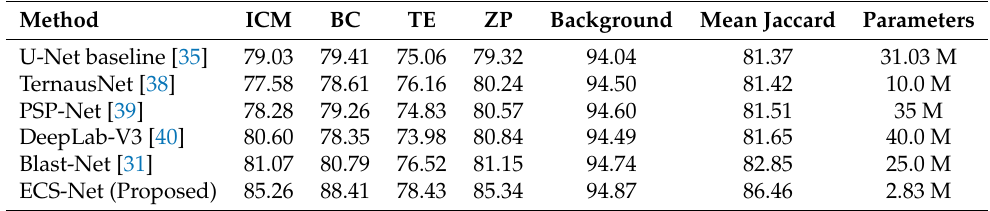
Figure 5. Visual results for separate embryo components segmentation. From left-to-right column: Example-1 images with ground truth, Example-1 Predicted results by ECS-Net, Example-2 images with ground truth, and Example-2 Predicted results by ECS-Net. Table 3. Numerical performance comparison of proposed ECS-Net with existing approaches for embryo component